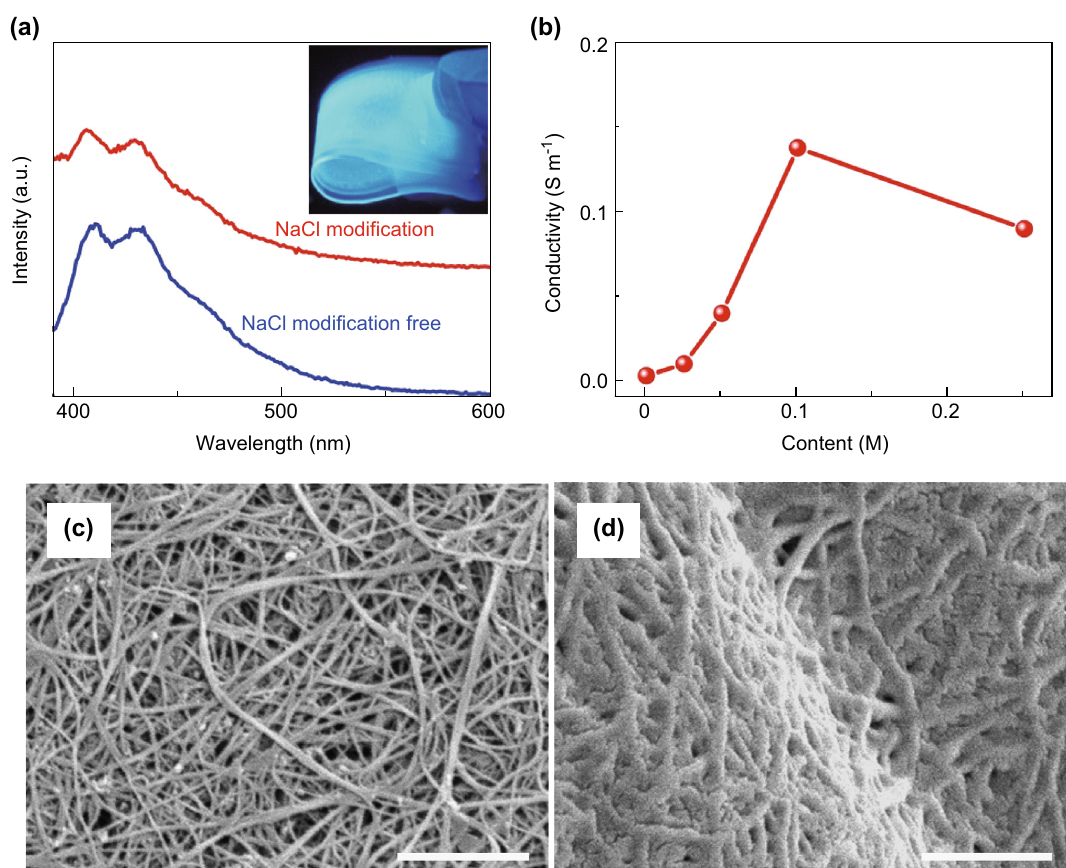
Fig. 2 a Fluorescence emission spectra of miwPU films with and without NaCl modification when excited at 365 nm (Inset is a photograph of the miwPU film under the excitation). b Ionic conductivities at various contents of NaCl in the miwPU film. c An SEM picture of CNT sheets (Scale bar is 1 l m). d An SEM picture of the CNT sheets on which PPy is electrodeposited (Scale bar is 1 l